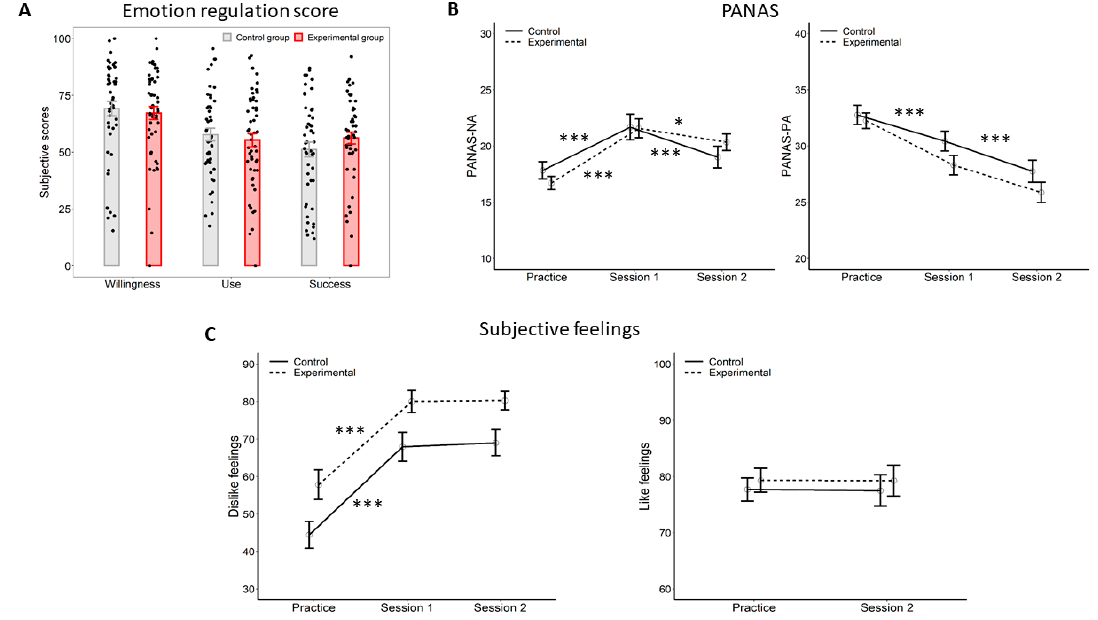
Figure 2. Emotion regulation scores and subjective feelings for the standard analysis (experimental group vs. control group). ( A ) Emotion regulation scores for the three subscales separately (willingness, use, or success) did not significantly differ between the two groups. ( B ) PANAS results. The two groups showed similar patterns for negative (left panel) and positive affect (right panel). ( C ) Dislike ratings of negative feedback (left panel) and like ratings of positive feedback (right panel). Vertical bars correspond to standard errors of the mean. *** p < 0.001, * p < 0.05.